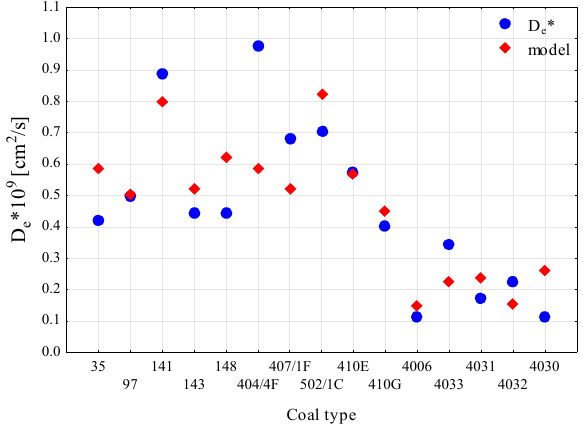
Figure 11. Value comparison between the effective diffusion coefficient De and the created regression model (Equation (12)).